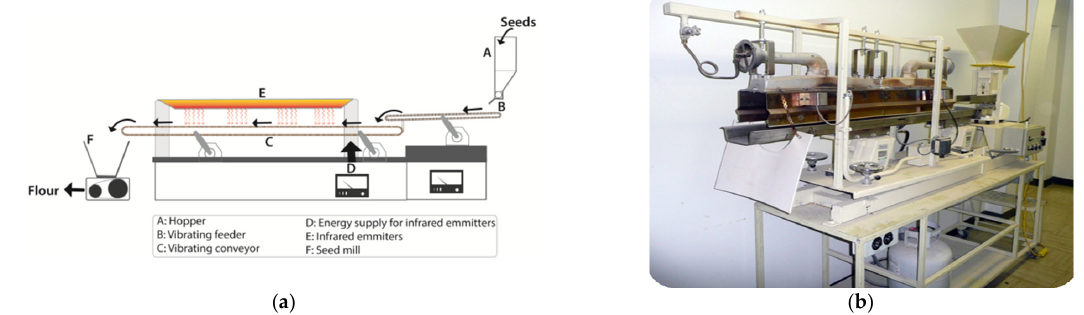
Figure 2. A schematic diagram ( a ) and an image ( b ) of a laboratory scale infrared heat treatment system. (Adapted with permission from Pathiratne [17] and Der personal collection, respectively).